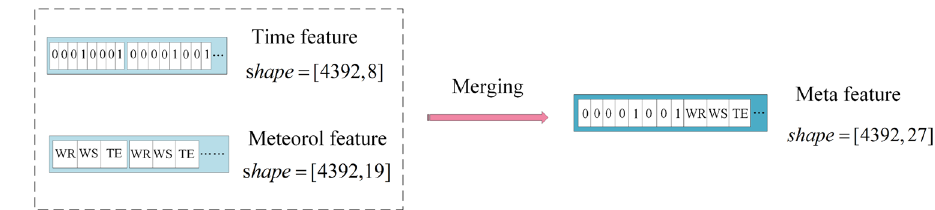
Fig. 9 Encoding external